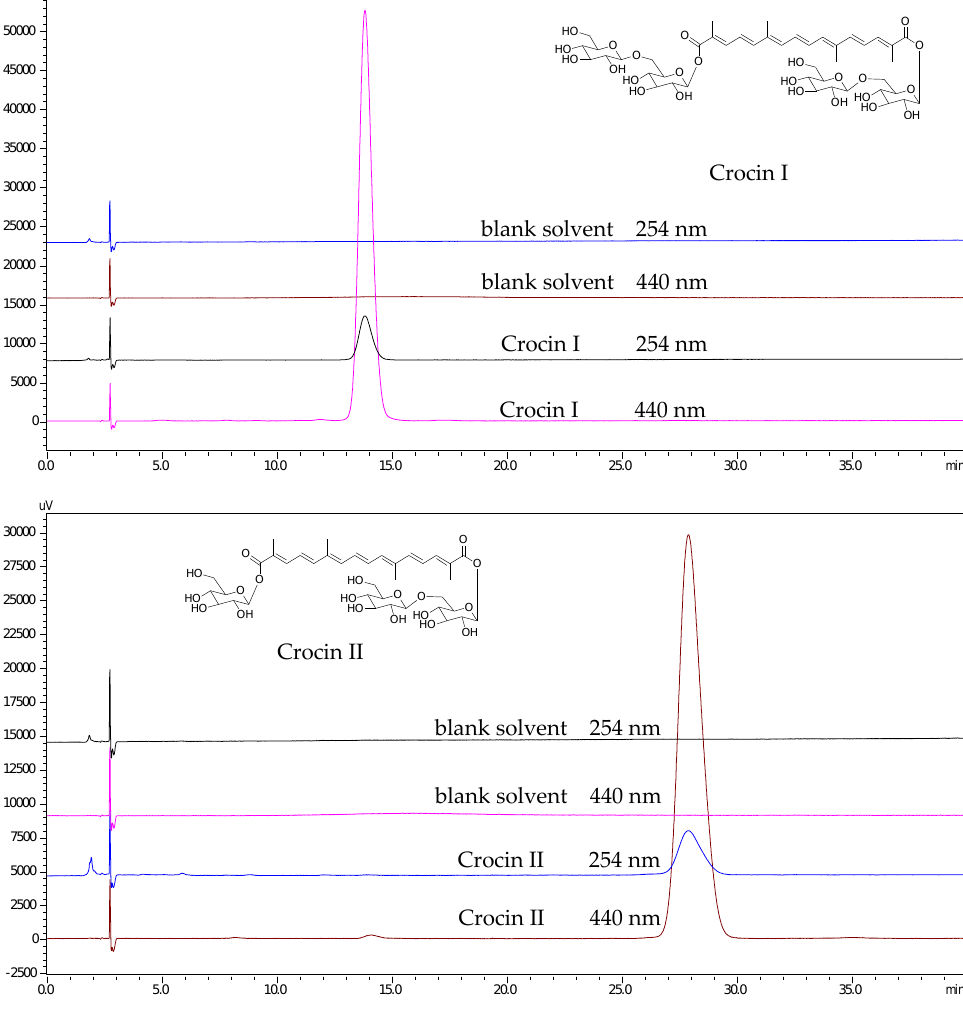
Figure 4. The HPLC chromatograms of crocins I and II after purification by HSCCC.